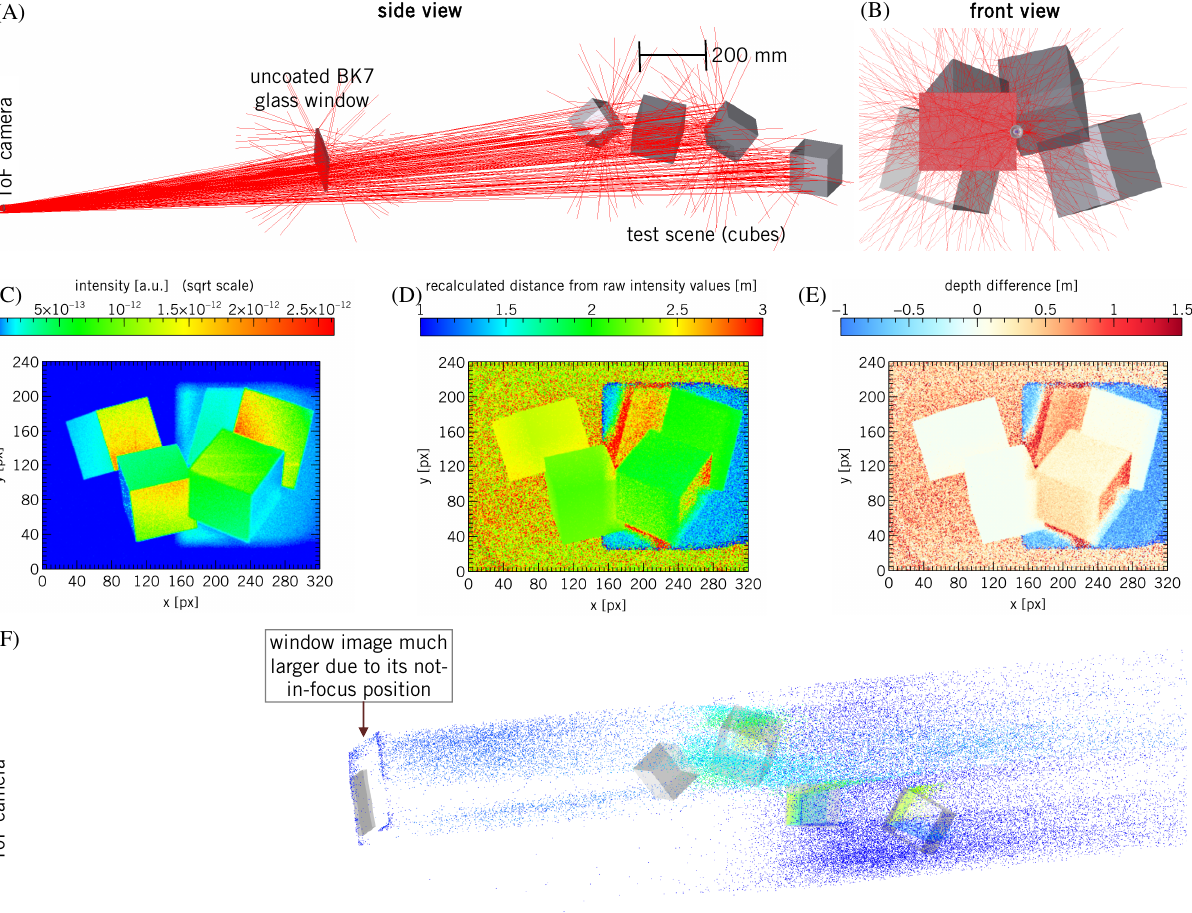
Figure 6. Test scene from Figure 4 after adding an uncoated BK7 window in front of the cubes. (A – B) Complete 3D scenery with ToF camera, cube objects and glass window. (C) Intensity distribution of the received light. (D) Calculated depth from the optical path length using the global magnification factor correspondence. (E) Depth difference between scene with and without glass win- dow (referenced to scene without glass window). (F) 3D plot of the ground truth object positions overlaid with ToF sensor